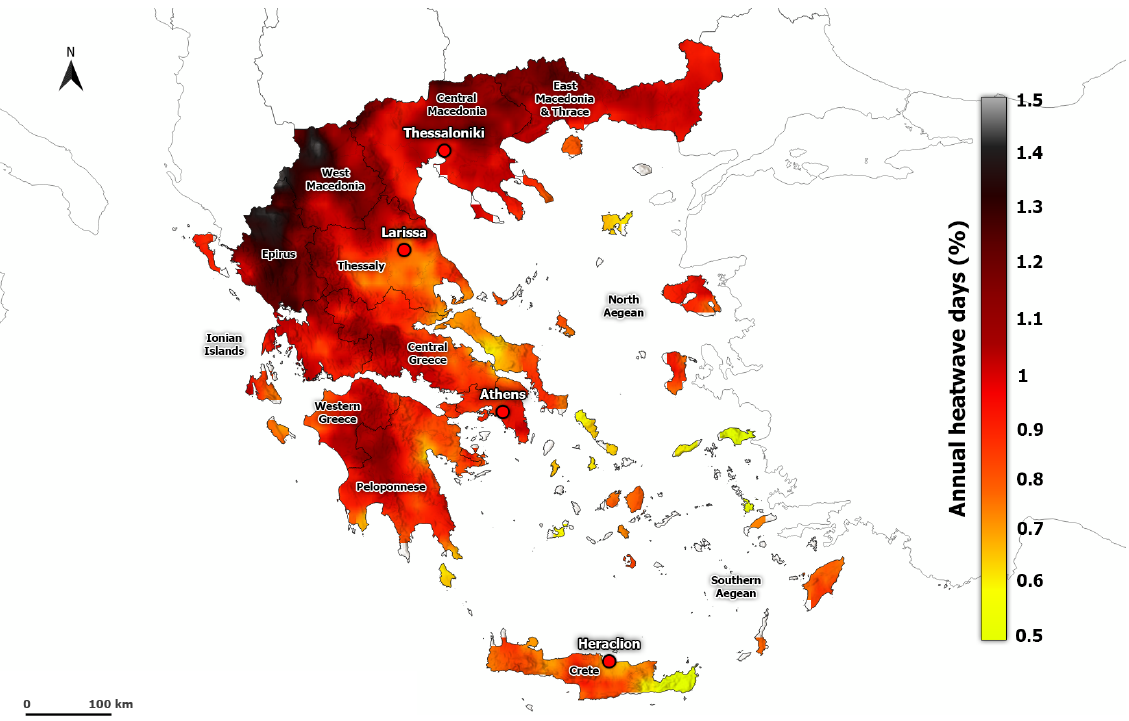
Figure 3. Spatial distribution of averaged HWF (%) based on all heatwave events calculated from ERA5-Land during the period 1950–2020.